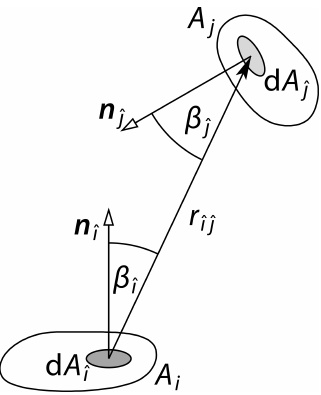
and n ˆ are the respective normal i j and d A ˆ , which are r ˆ apart. i j i ˆ j